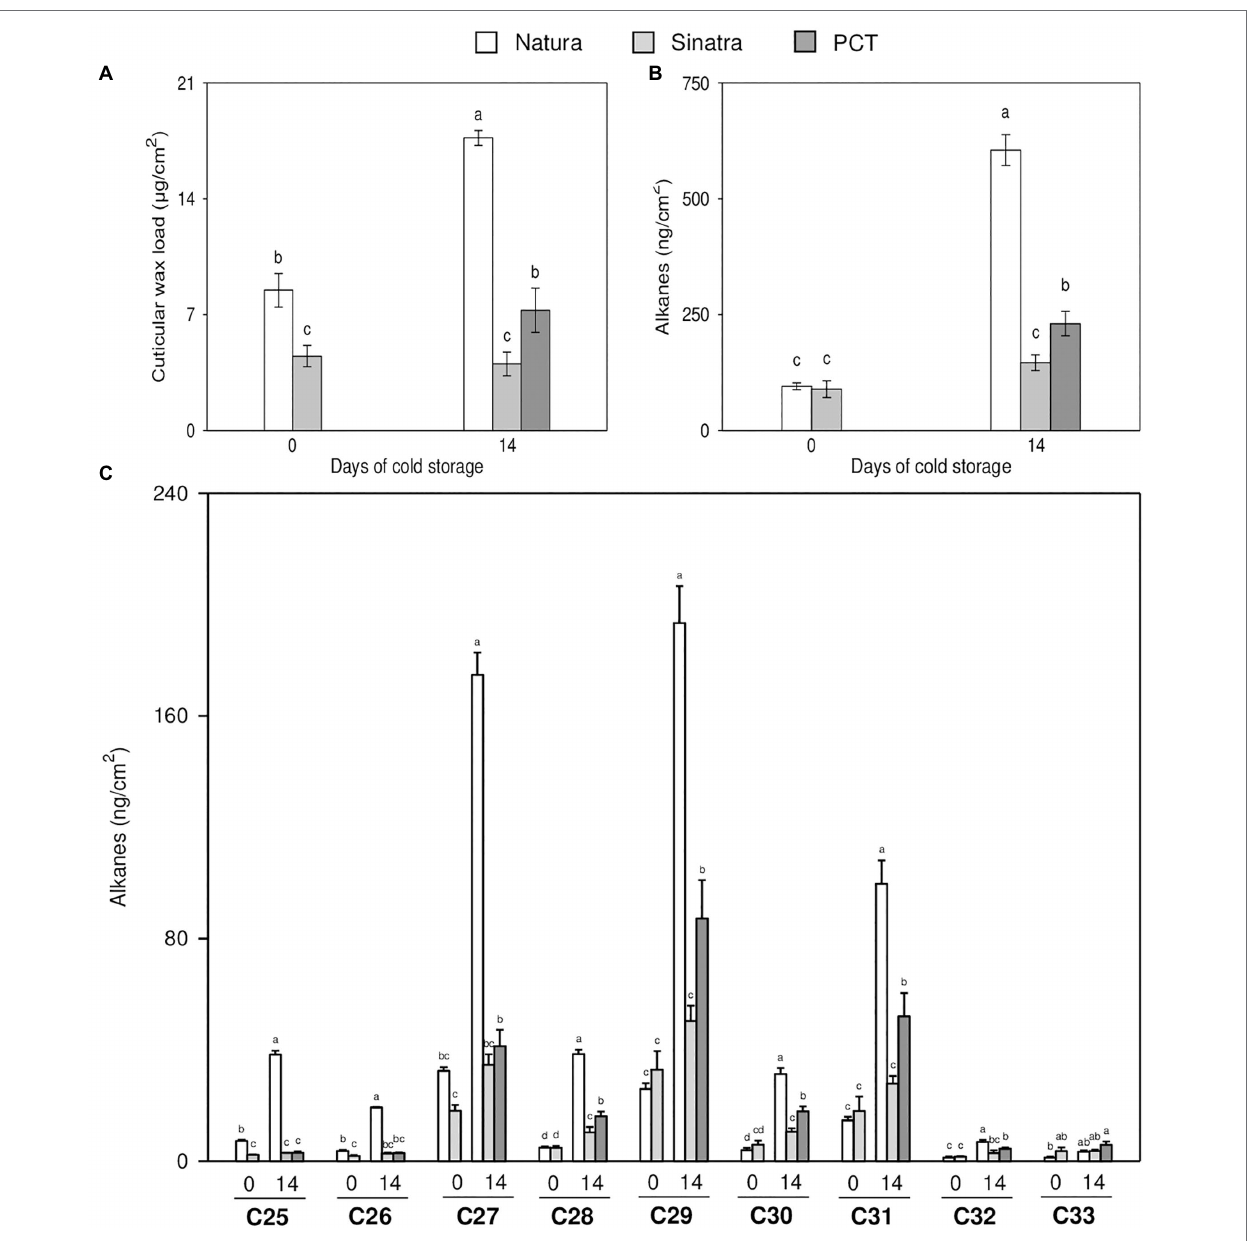
FIGURE 3 | Cuticular wax load (A) , total alkane content (B) , and individual alkanes per surface (C) measured in zucchini ‘Natura’ and ‘Sinatra’ fruit, at harvest and after 14 days of storage at 4 ° C, including preconditioned ‘Sinatra’. Data presented are means ± SE of triplicate samples of six fruits each. Different letters indicate significant differences according to Duncan’s test ( p <